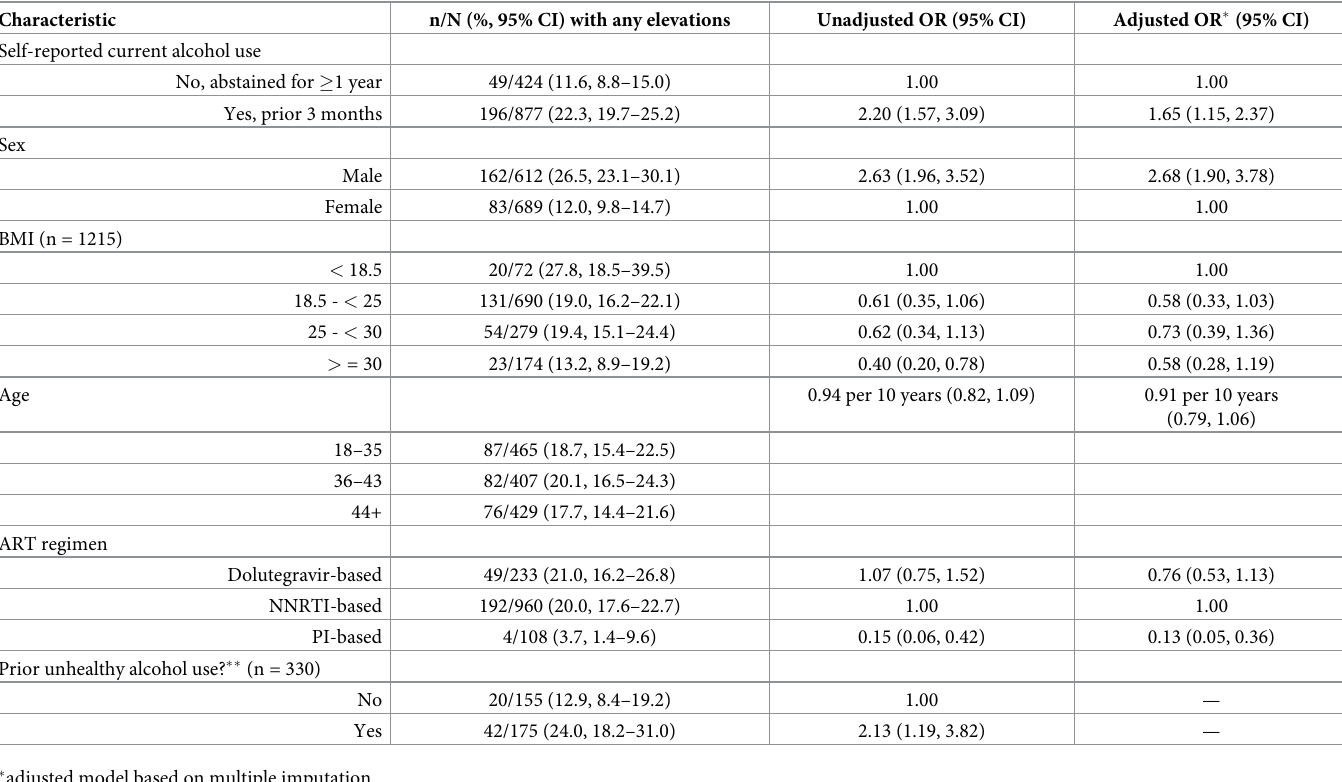
Table 2. Transaminase elevations ( > = 1.25x ULN) by participant characteristics, among persons screened for the ADEPTT Study (n = 1301).